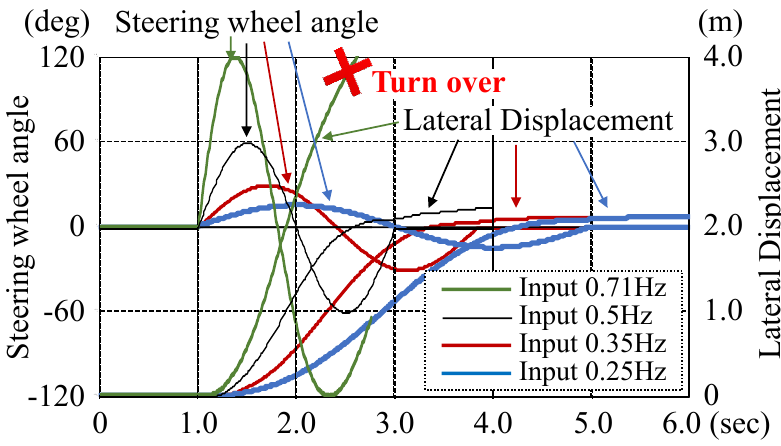
Figure 9. Steering angle proportioned to square of frequency results in sudden turnover (I = 50). Only steering input frequency f was changed, while maintaining steering input angle MA = ± 60 deg, without maintaining LD , as shown in Figure 10. The minimum residual load of the front left wheel (inner wheel) is almost zero at f = 0.71 Hz, and the inner wheel lifts clearly at f = 1.0 Hz. It can be understood that front inner wheel lifting is caused not only by the large steering angle input but also directly by quick steering input.